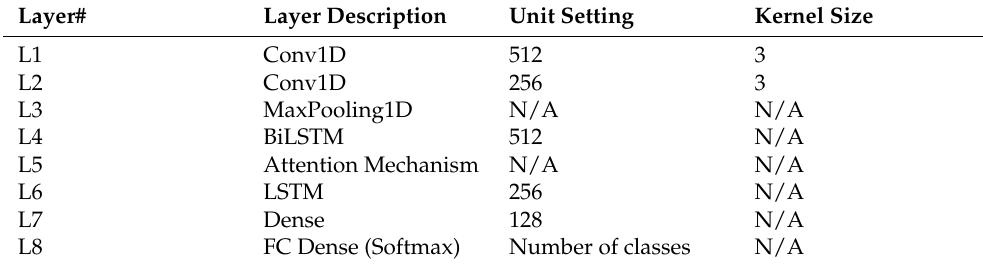
Table 5. Model 1—The proposed A-CRNN model architecture.